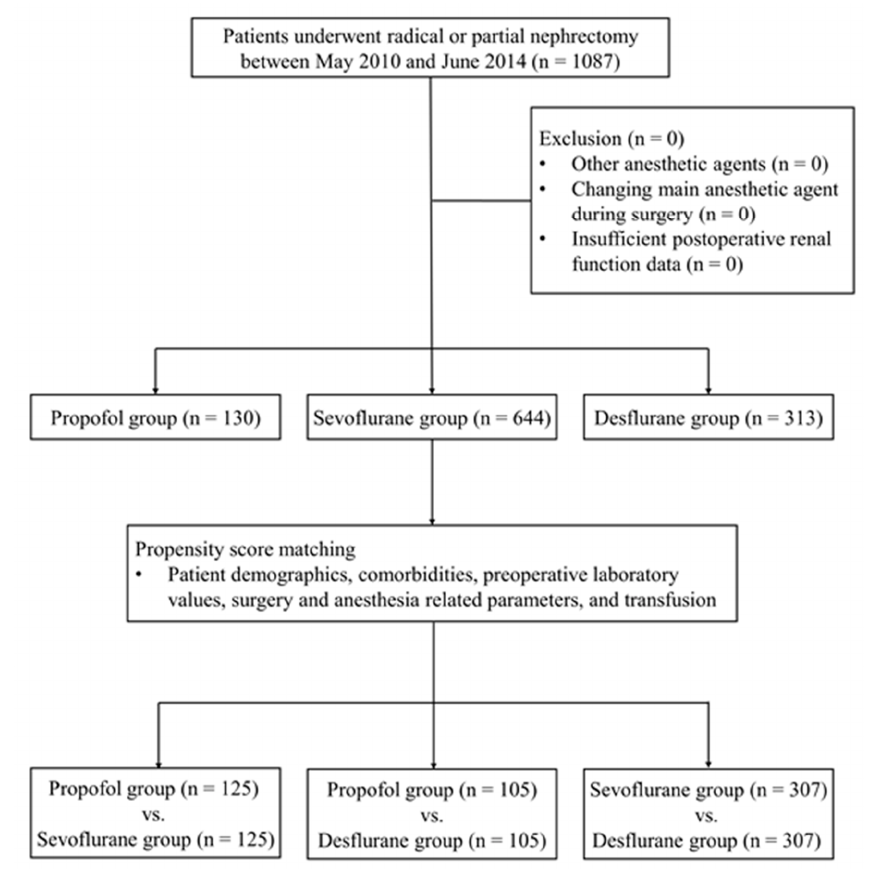
Figure 1. Flow diagram of the present study. Table 2. Comparison of incidence of primary and secondary outcomes between patients according to the main anesthetic agents during surgery before and after propensity score